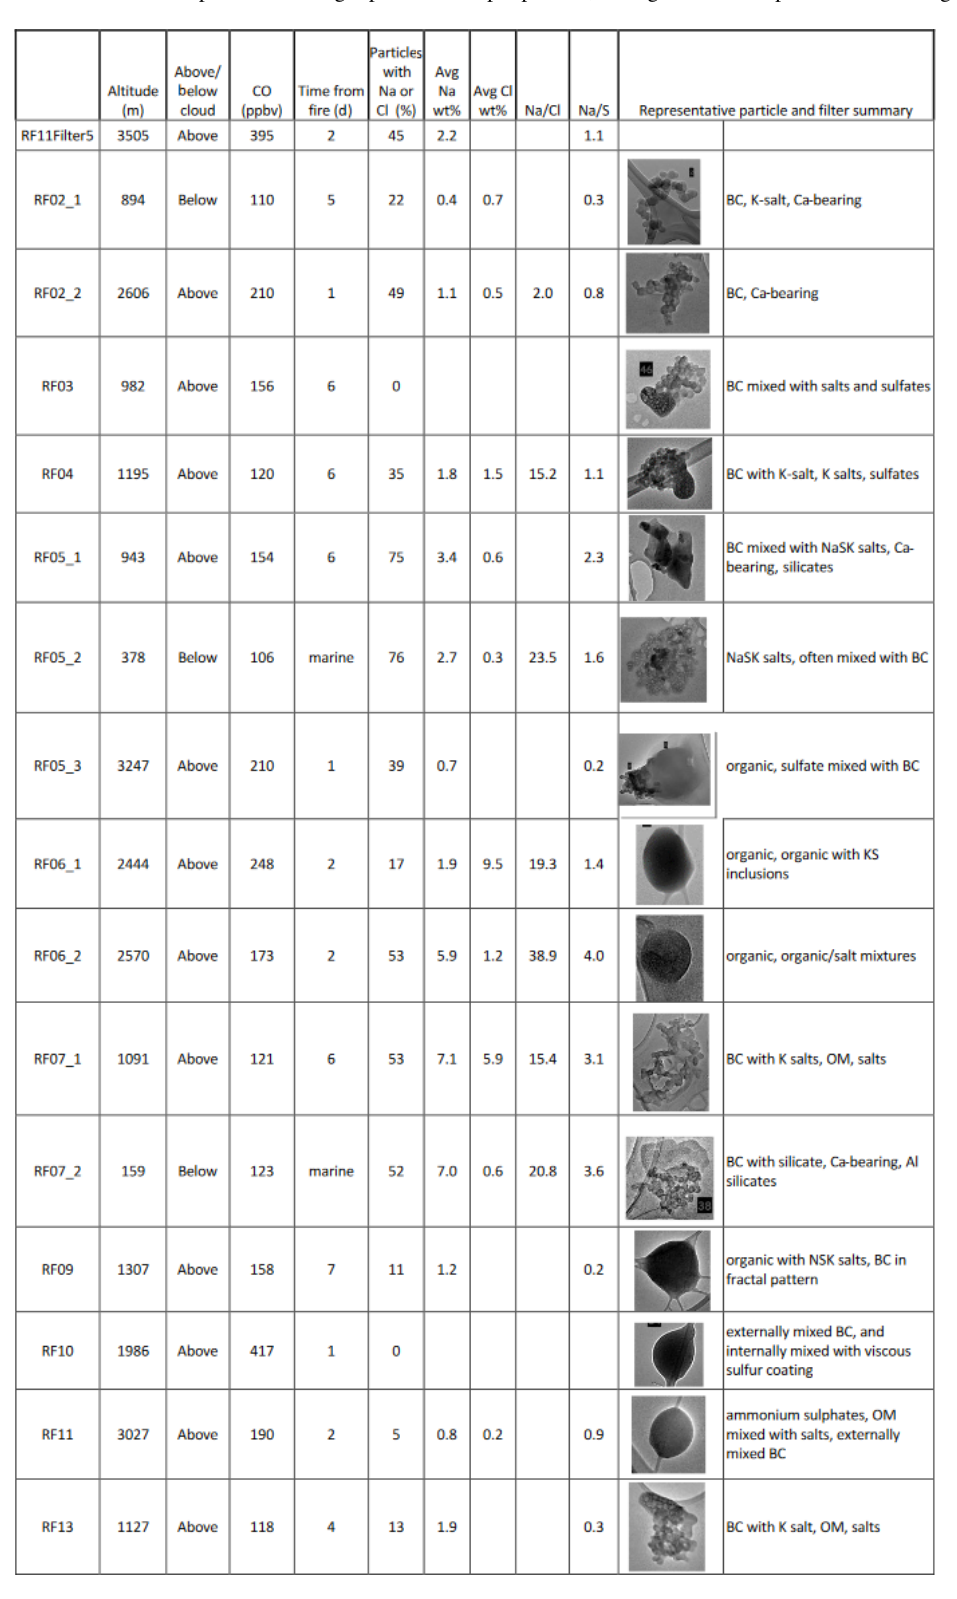
Table 4. Na-dominant aerosols on ORACLES filters with sampling location, CO levels, time from source and percentage of particles on the filter with either Na or Cl. The ratios represent the weight percent ratio per particle, averaged across all particles containing the